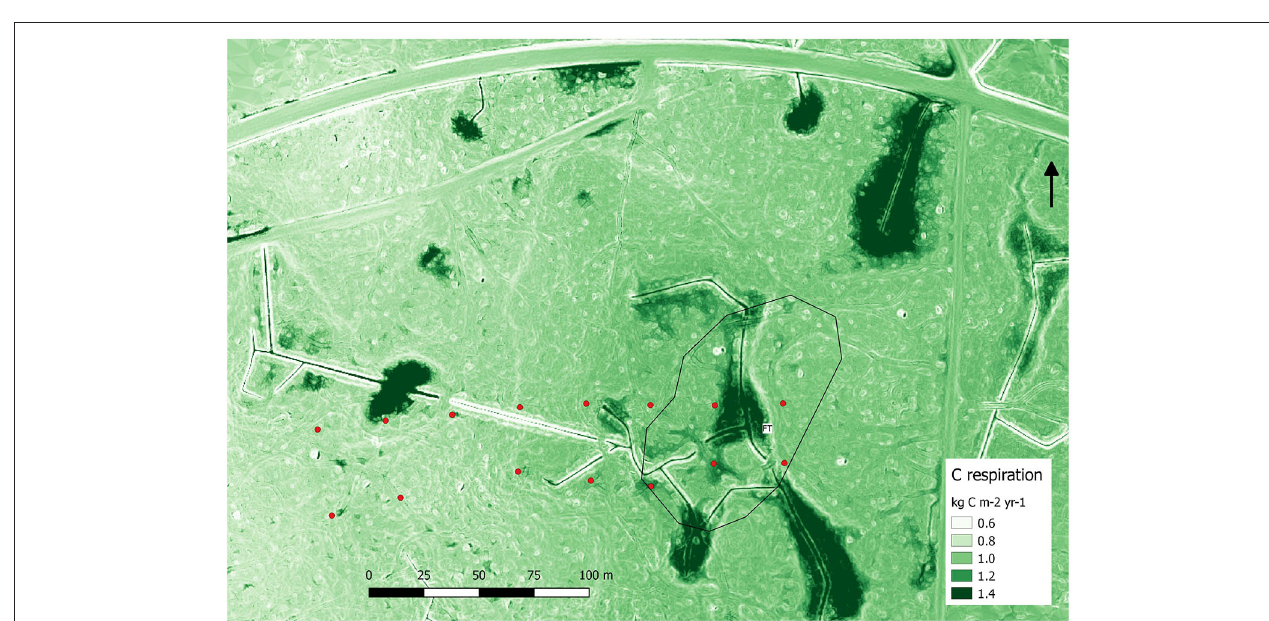
FIGURE 8 | Predicted soil C respiration, kg C m − 2 yr − 1 from equation in Figure 7D . Red dots: respiration measurement points.